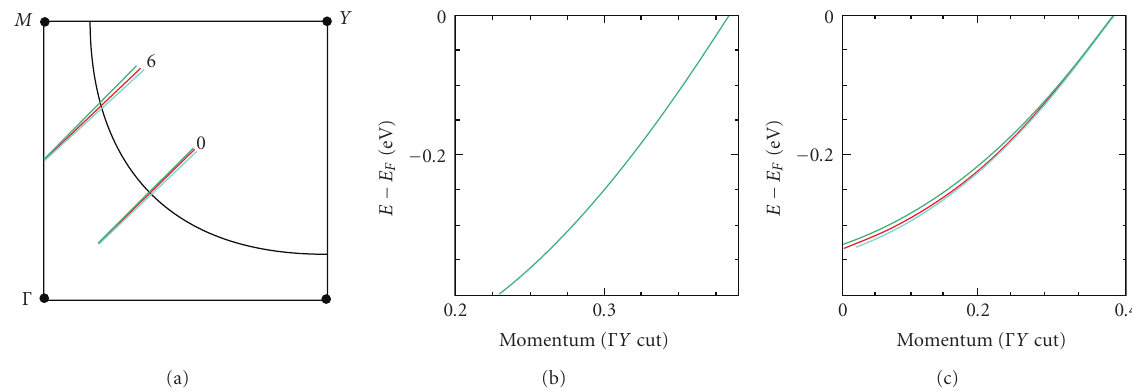
Figure 12: (a) Estimated azimuthal variation for cuts at and far o ff node indicated by the teal colored cuts relative to the red cut ( Γ - Y ). (b-c) Tight binding model for the nodal and o ff nodal cuts, respectively, representing the expected variation in dispersion due to the misalignment.